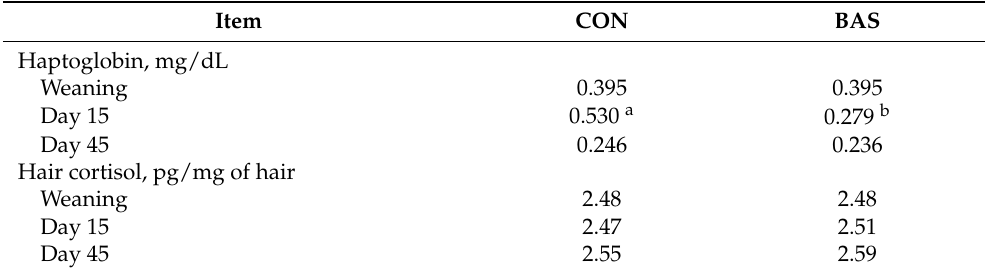
Figure 1. Plasma haptoglobin concentrations ( A ) and hair cortisol from the tail switch ( B ) from beef calves receiving (BAS) or not (CON) a bovine appeasing substance at weaning (day 0). Adapted from Schubach et al. [80]. Table 2. Physiological responses of newly weaned beef steers receiving (BAS) or not (CON) a bovine appeasing substance at weaning 1,2 .